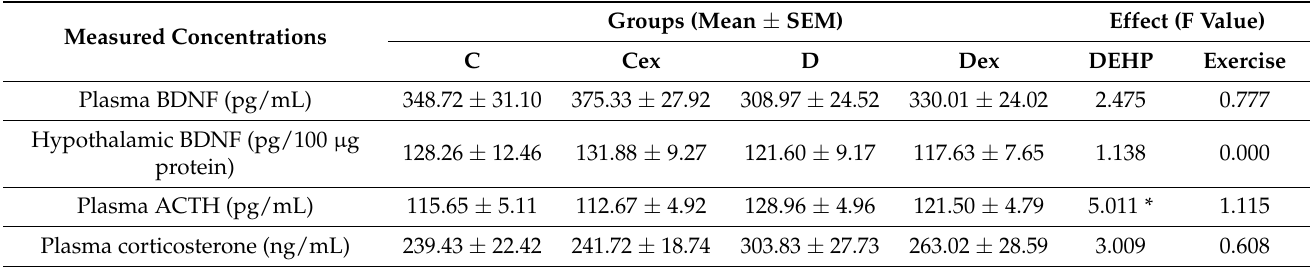
Table 2. Effects of prenatal DEHP exposure and childhood exercise on expressions of BDNF and stress-related hormones. Measured